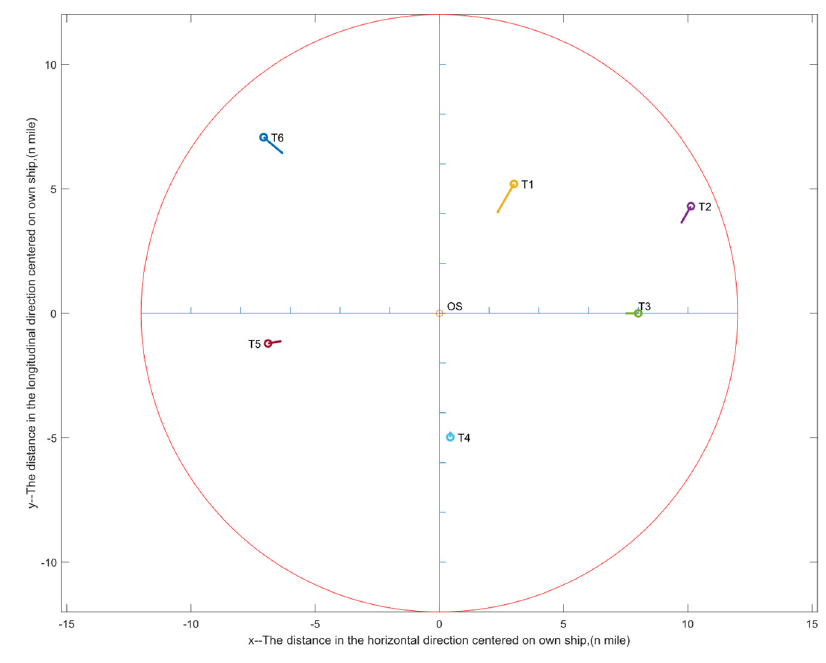
Figure 6. Multiship encounter situation